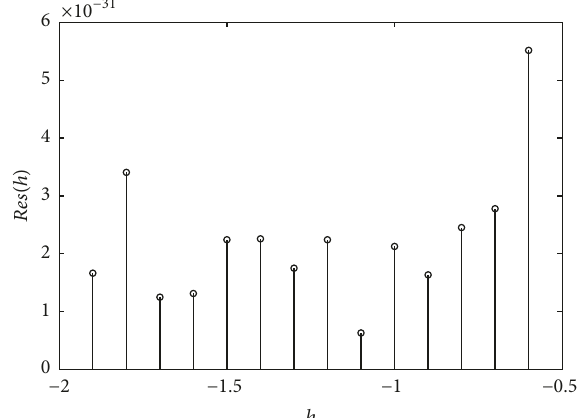
Figure 7: The valid region ℎ of the explicit spectral PIM when 𝑁 = 10 for Example